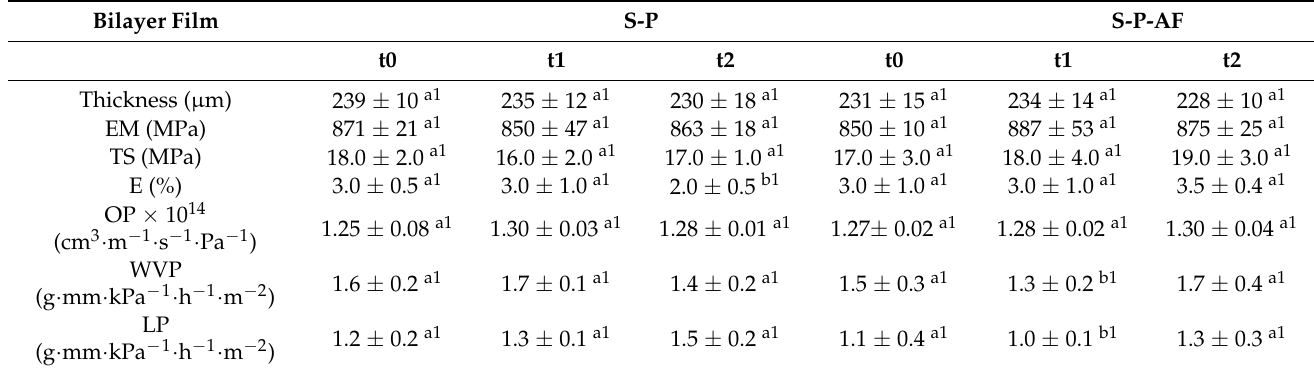
Different superscript letters (a,b) indicate significant differences among formulations ( p < 0.05). Different super- script numbers indicate significant differences between the three storage times ( p <